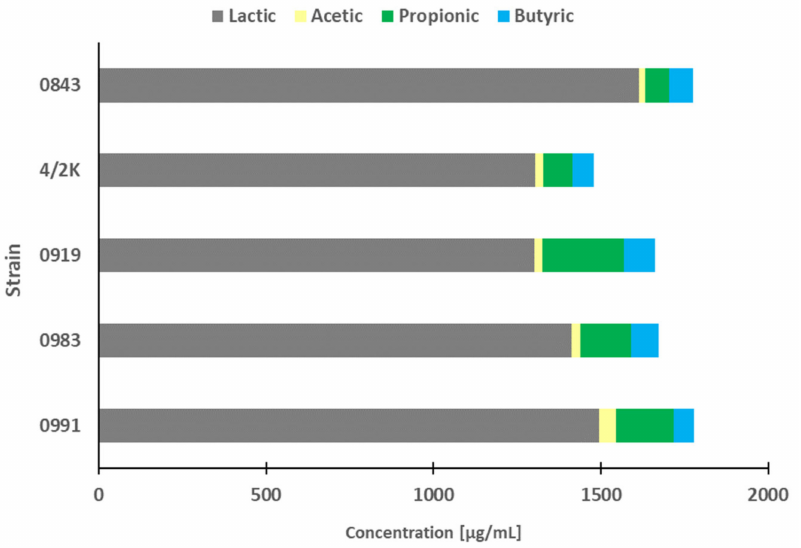
Figure 9. Lactic acid (LA) and short-chain fatty acids (SCFA) profiles in post-fermentation media (PFM) of selected lactic acid bacteria (LAB) with the strongest antiproliferative